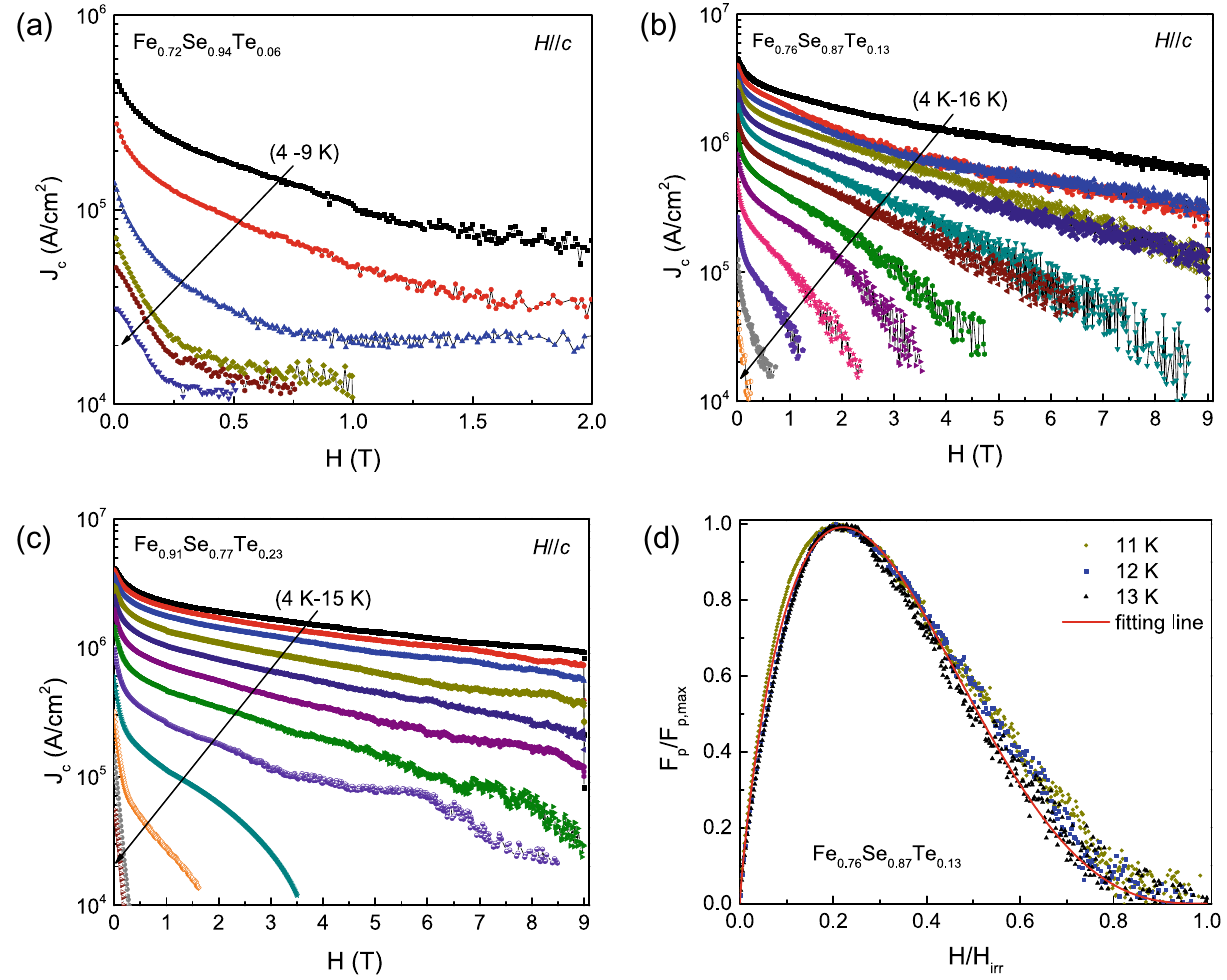
Figure 7. Magnetic field dependence of critical current density J c at various temperatures for ( a ) Fe 0.72 Se 0.94 Te 0.06 , ( b ) Fe 0.76 Se 0.87 Te 0.13 , and ( c ) Fe 0.91 Se 0.77 Te 0.23 thin films. ( d ) Normalized flux pinning force versus reduced magnetic field at 11, 12 and 13 K for Fe 0.76 Se 0.87 Te 0.13 thin film. Solid line is the fitting curve using the Dew-Hughes